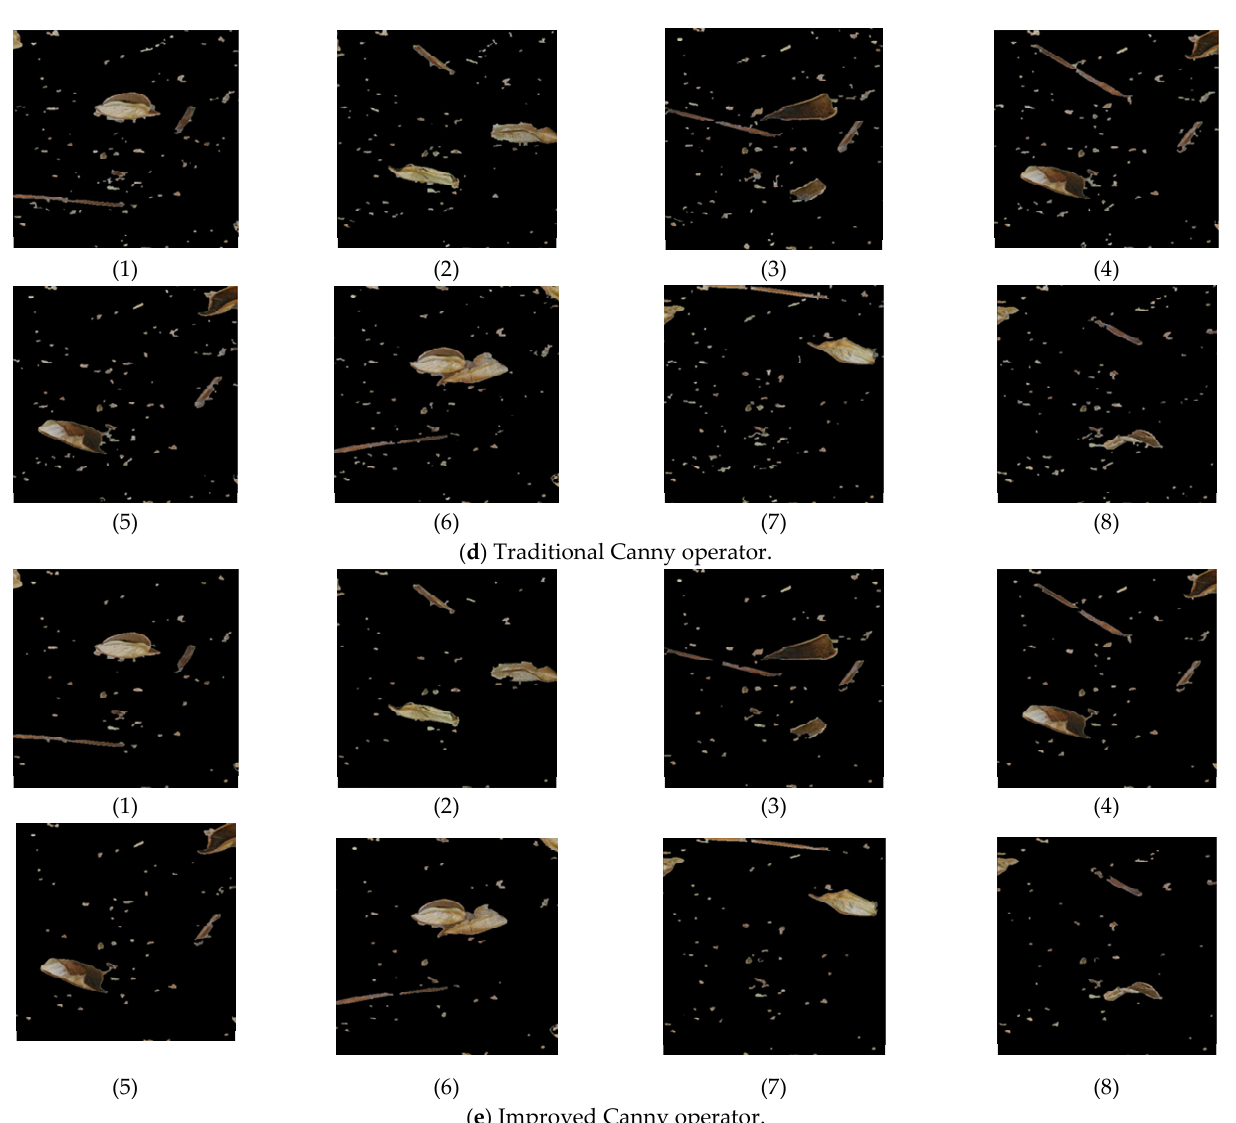
Figure 17. Comparison of processing results of different algorithms.